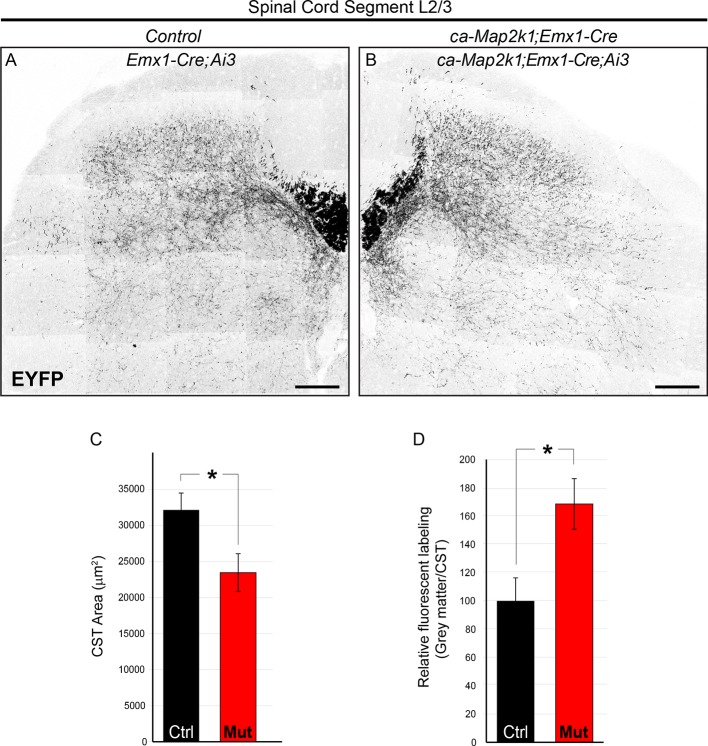
ca-Map2k1;Emx1-Cre mice exhibit alterations in the pattern of corticospinal outgrowth in the spinal cord similar to ca-Map2k1;Neurod6-Cre mutants.(A–D) The entire pattern of corticospinal branching can be visualized in Emx1-Cre;Ai3 mice. P30 ca-Map2k1;Emx1-Cre;Ai3 mice showed a significant reduction in the area of corticospinal labeling in the white matter of lumbar spinal cord segments (B and C) when compared to Emx1-Cre;Ai3 controls (A and C) (n=4, mean ± SEM, *p=0.01, scale bar=100 µm). When the amount of fluorescent labeling in the grey matter relative to the white matter was assessed (D), mutant mice exhibited an increased extent of axonal branching per axon (n=4, mean ± SEM, *p=0.001).